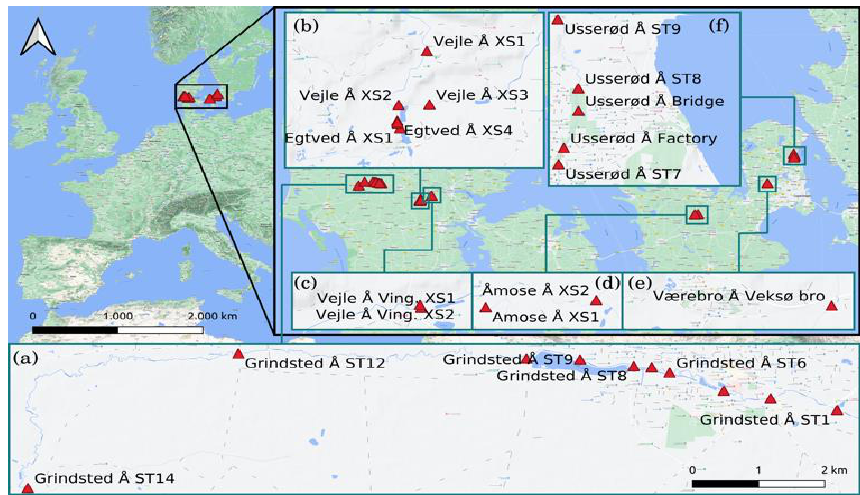
Figure 1. Location of the case studies used to test WATER (27 case studies in total located in Denmark). ( a – f ) are zooms of the case studies’ locations.